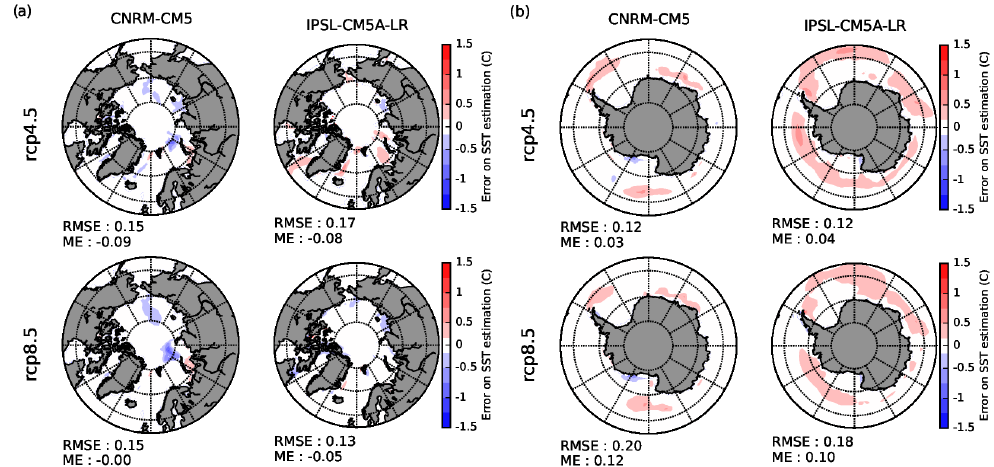
Figure 9. Mean error in the estimation of SST with respect to the corresponding original AOGCM scenario after applying the analogue method for sea ice, the quantile–quantile method for SST, and the correction for SST and SIC consistency for the Arctic (a) and the southern oceans (b)